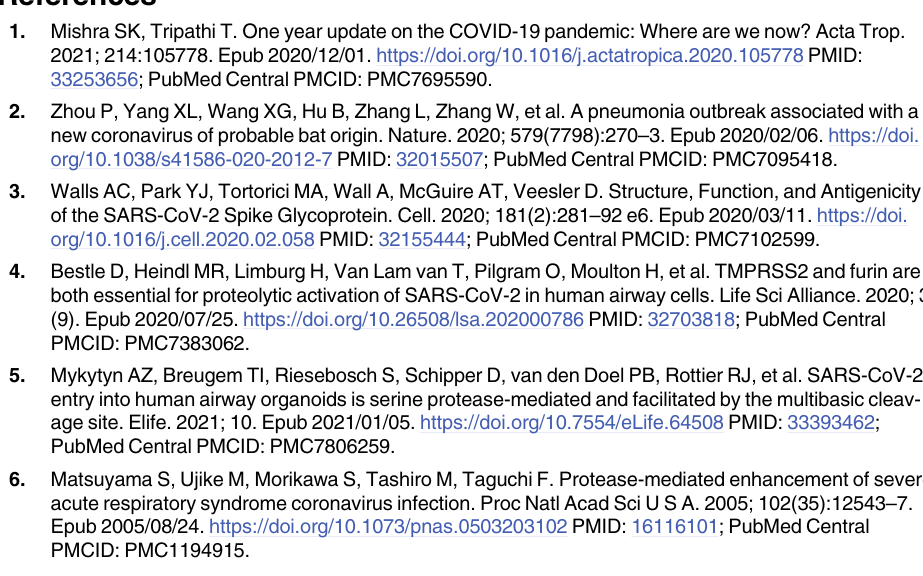
S5 Fig. Summary of statistical analysis. One-way ANOVA was used for the statistical analysis of the data found in Fig